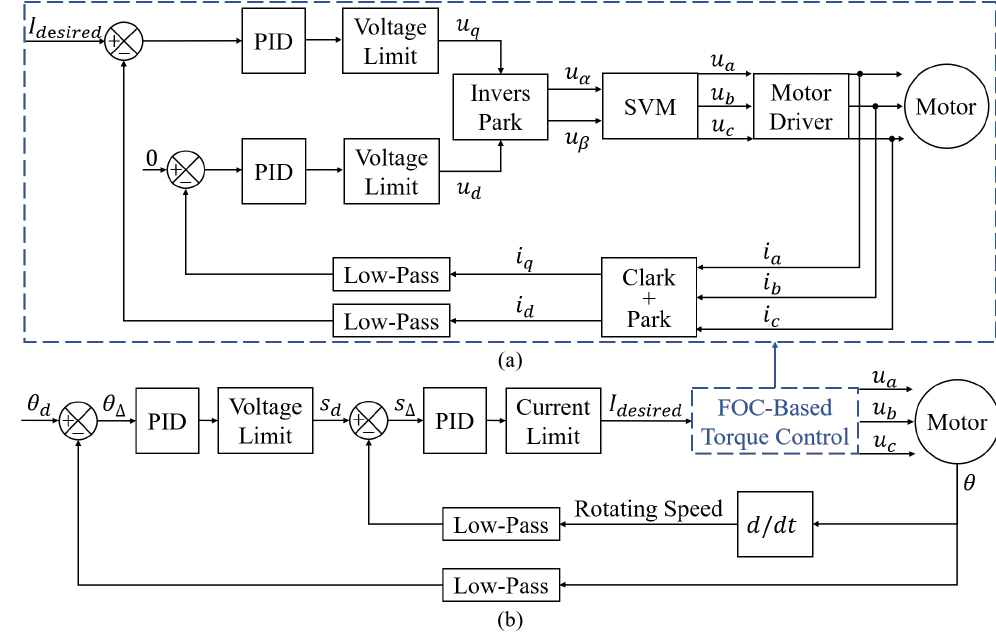
Figure 8. ( a ) Flowchart of FOC-based torque control. ( b ) Flowchart of FOC-based angular closed-loop torque